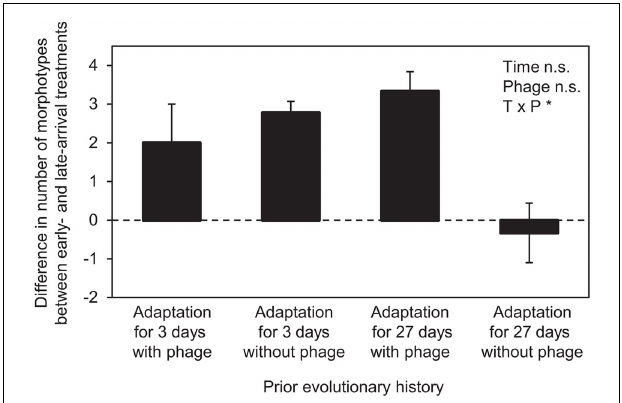
FIGURE 2 | Comparison of diversification of focal genotypes immigrating early and late. Data show the difference in the mean number of morphotypes derived from the focal genotype ± SEM ( n = 3) measured at the end of the experiment (on days 8–10).Two-way ANOVA results are indicated as in Figure 1 (see Table 4 ).